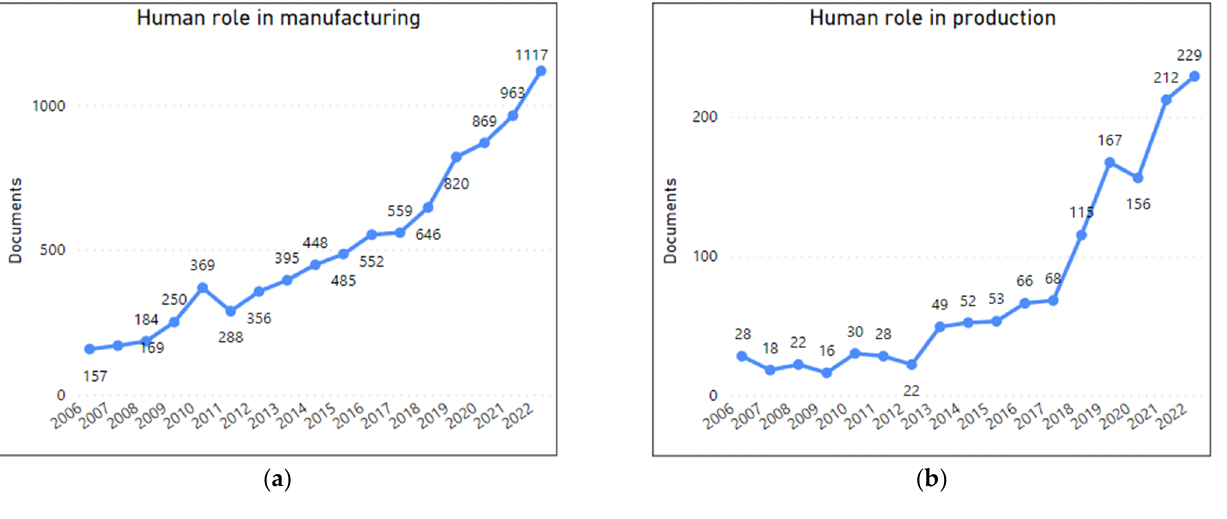
Figure 1. ( a ) Human/s role in manufacturing—years 2006–2022, 8627 documents in period, ( b ) Human/s role in production—years 2006–2022, 1331 documents in period.